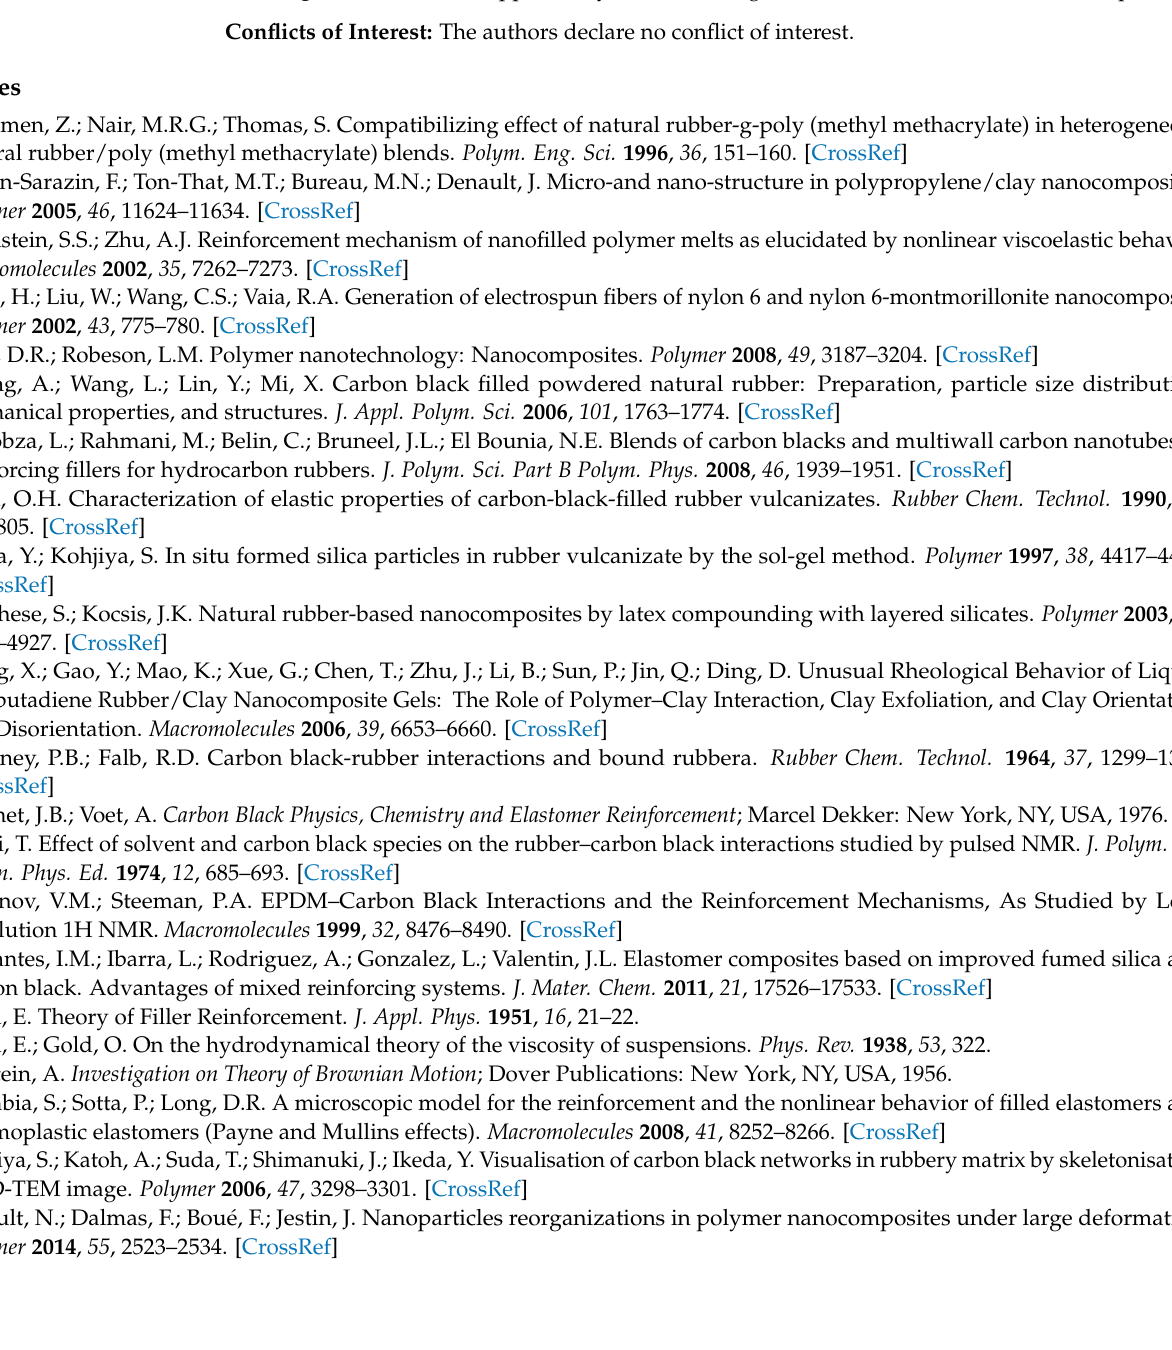
Supplementary Materials: The following are available online at https://www.mdpi.com/article/10 .3390/polym13223922/s1, Figure S1: Comparison of macroscopic tensile stress curves and mi- croscopic stresses for PDMS, Figure S2: (a) Young’s modulus mapping of HAF-CB (4.9 vol%, Table S1: Young’s modulus E Unstr , E str of deformed and undeformed rubber for PDMS, and stresses σ calculated by Equation (3), Table S2: Local stress distribution of interface and rubber regions for CB/IR of CB (4.9 vol%, 10 phr) and CB (13.2 vol%, 30